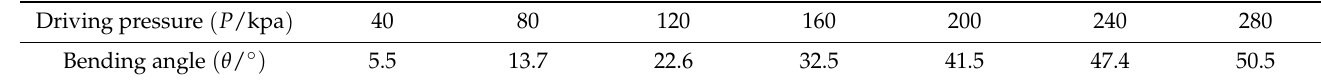
Figure 8. Comparison between simulation curve and the theoretical curves.